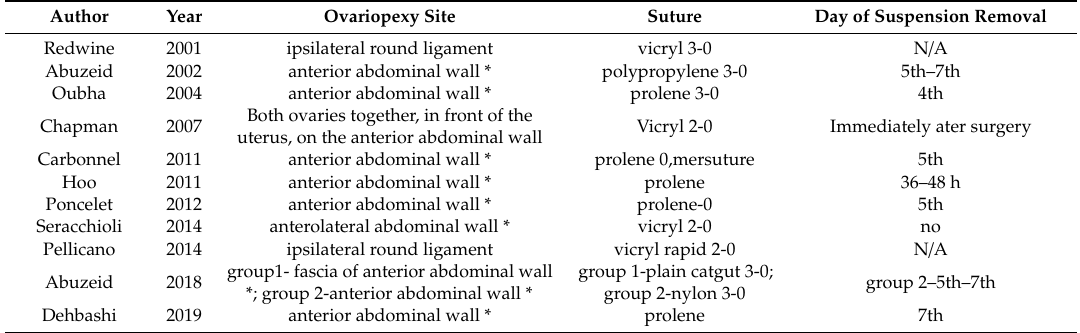
Table 1. Summary of Ovariopexy